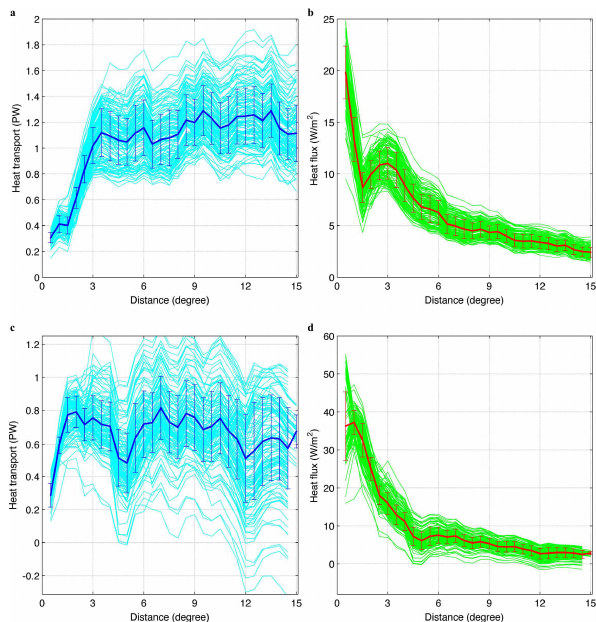
Figure 9. Two-hundred estimates of heat transport (in a and c ) and air–sea heat flux (in b and d ) based on 200 randomly selected sam- ples of pairs. (a) and (b) are estimates under TS/TD conditions and (b) and (c) for hurricanes. The mean of 200 estimates is highlighted in blue for TS/TD and in red for hurricanes. Error bars represent the standard error.